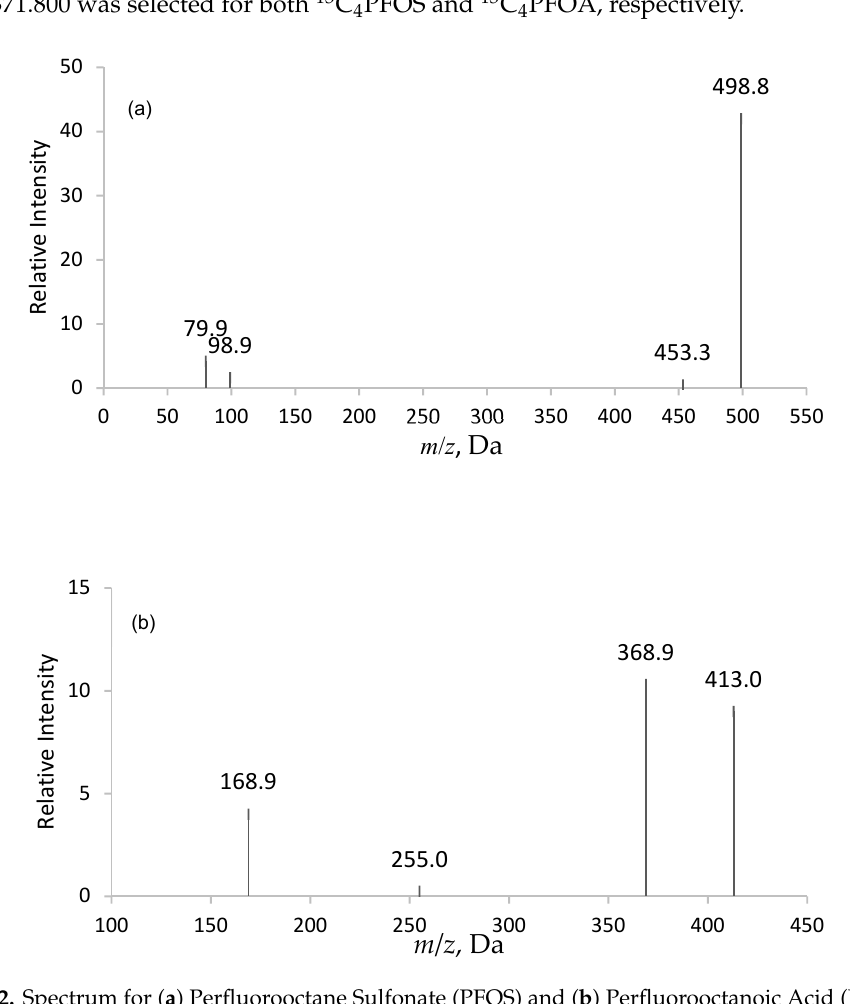
Figure 2. Spectrum for ( a ) Perfluorooctane Sulfonate (PFOS) and ( b ) Perfluorooctanoic Acid (PFOA).